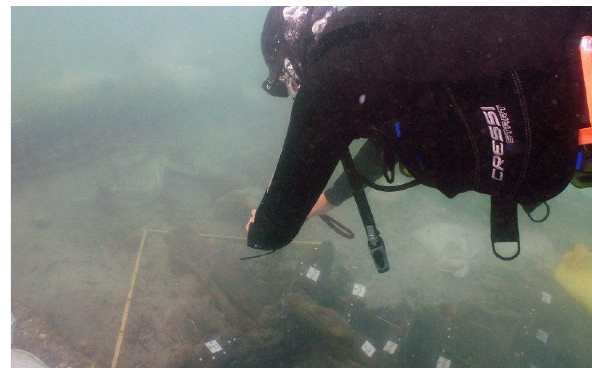
Figure 7 . Image acquisition phase during the underwater photogrammetric survey of the Roman shipwreck in Torre Santa Sabina.